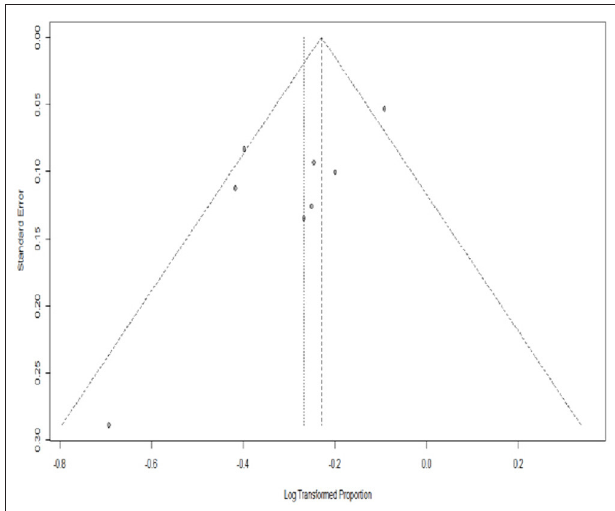
FIGURE 5 | Funnel plot standard error by remission rate for AAV. PLN, log transformation (By R